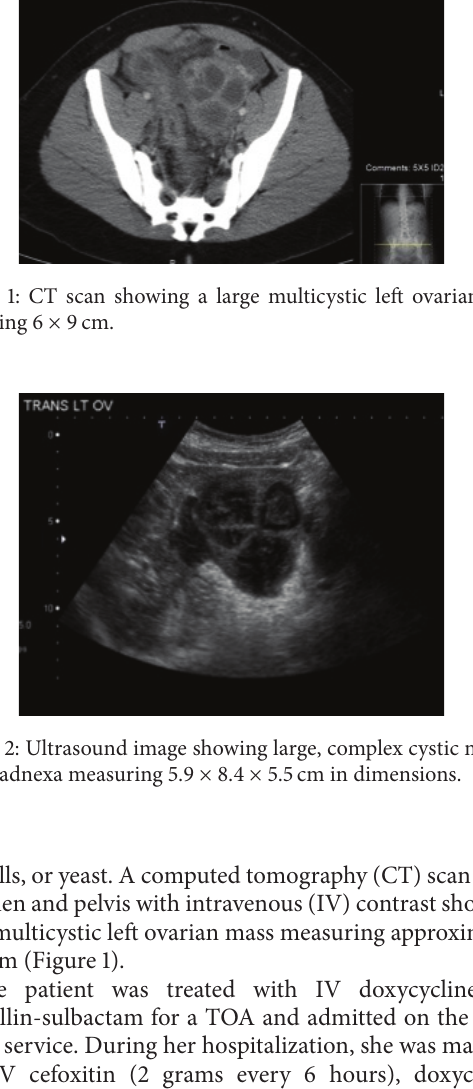
clue cells, or yeast. A computed tomography (CT) scan of the abdomen and pelvis with intravenous (IV) contrast showed a large, multicystic left ovarian mass measuring approximately 6 × 9 cm (Figure